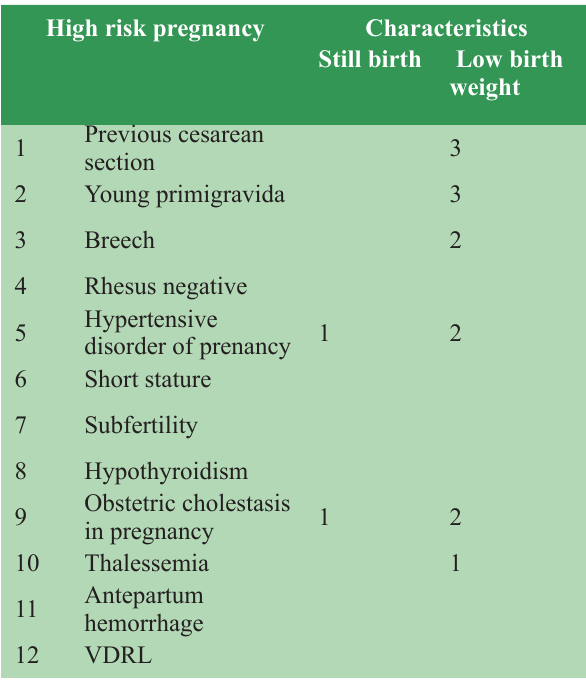
Table 2. Fetal outcome in relation to high risk